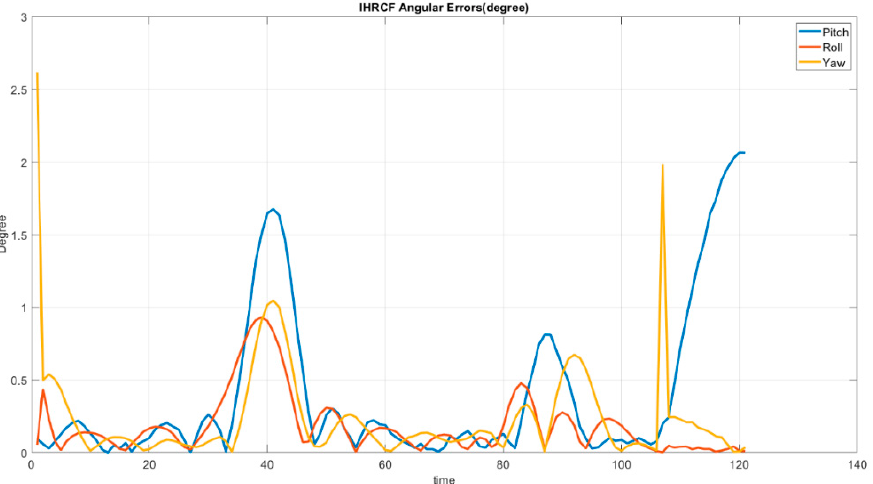
Figure 17. IHRCF-based Stewart platform Euler angles estimation error along the X (blue), Y (red), and Z (yellow) axes.